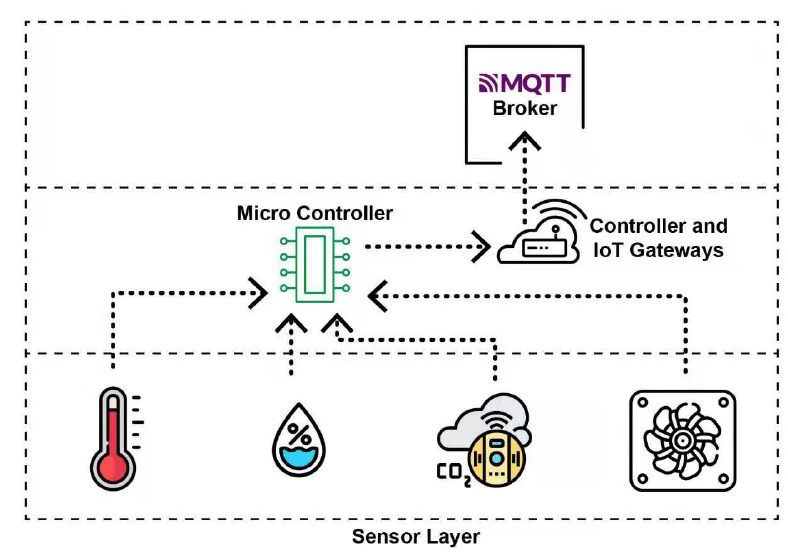
Figure 13. IoT Layer